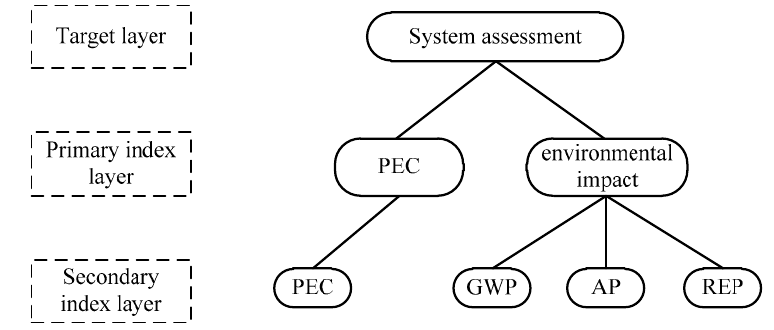
Figure 6. The structure of analytic hierarchy process.